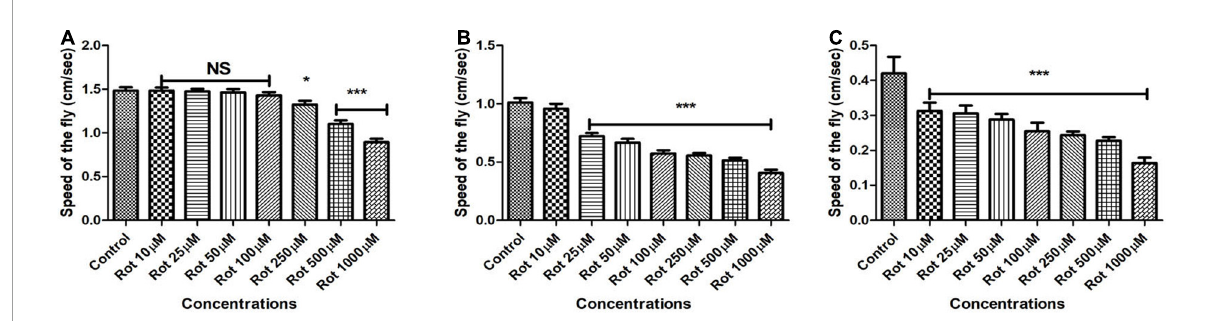
FIGURE2 Assessing the climbing ability of Drosophila as determined by negative geotaxis assay after exposure to multiple concentrations of rotenone (10, 25, 50, 100, 250, 500, and 1,000 µ M). About 500 µ M of rotenone-induced clear mobility defects in the adult male fly of early health span on 5th day (A) , 25 µ M rotenone in late health span fly on the 2nd day (B) and 10 µ M rotenone in transition phase fly on the 2nd day (C) and there was no mortality at the selected time points. Observation of mere mobility defects but not mortality of fly is the reason behind selecting above mentioned toxin concentrations and durations of toxin exposure in adult life stage-specific fashion. Hence, these concentrations of toxin and window period of exposure were selected for further studies. Data were collected every 24 h for each group. One-way ANOVA followed by the